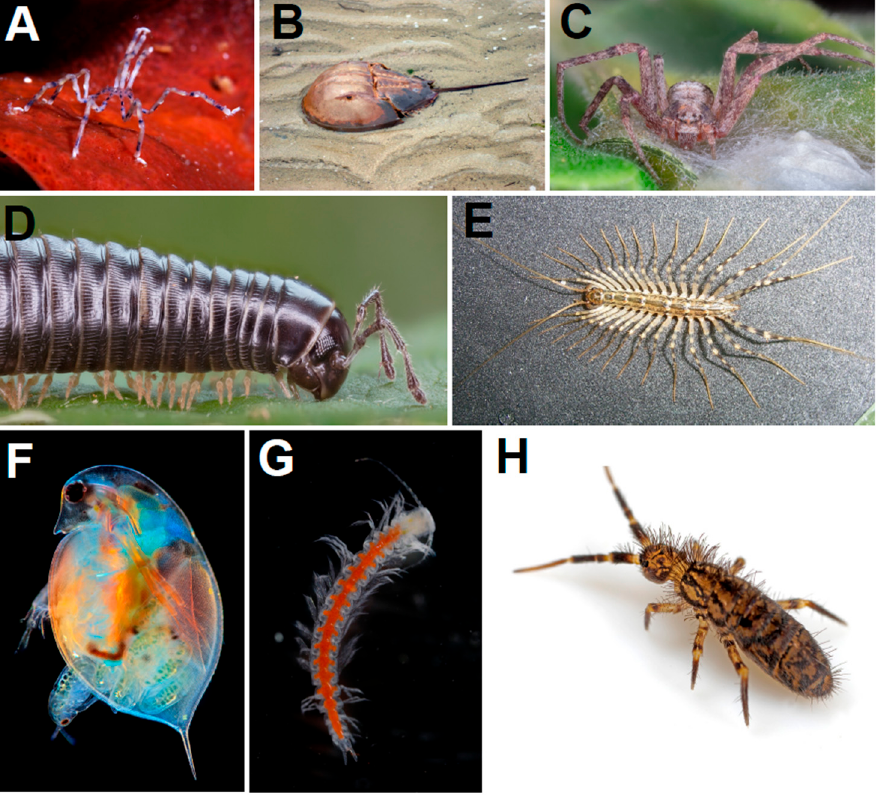
Figure 2. Present diversity of arthropods ( A ) pycnogonid Endeis flaccida (chelicerate); ( B ) xiphosuran Limulus polyphemus (chelicerate); ( C ) spider Philodromus aureolus (arachnid: chelicerate); ( D ) millipede Cylindroiulus caeruleocinctus (myriapod); ( E ) centipede Scutigera coleoptrata (myriapod); ( F ) branchiopod Daphnia sp. (pancrustacean); ( G ) remipede Morlockia williamsi (pancrustacean); ( H ) hexapod Orchesella villosa (pancrustacean). Image sources: Wikimedia Commons; ( G ) Jørgen Olesen.